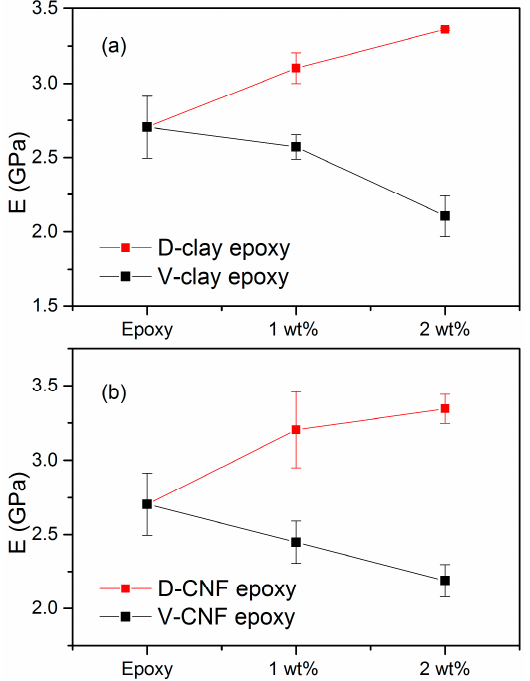
Figure 9. Young’s modulus of composites with different filler loading ( a ) MMT clay ( b ) CNF.